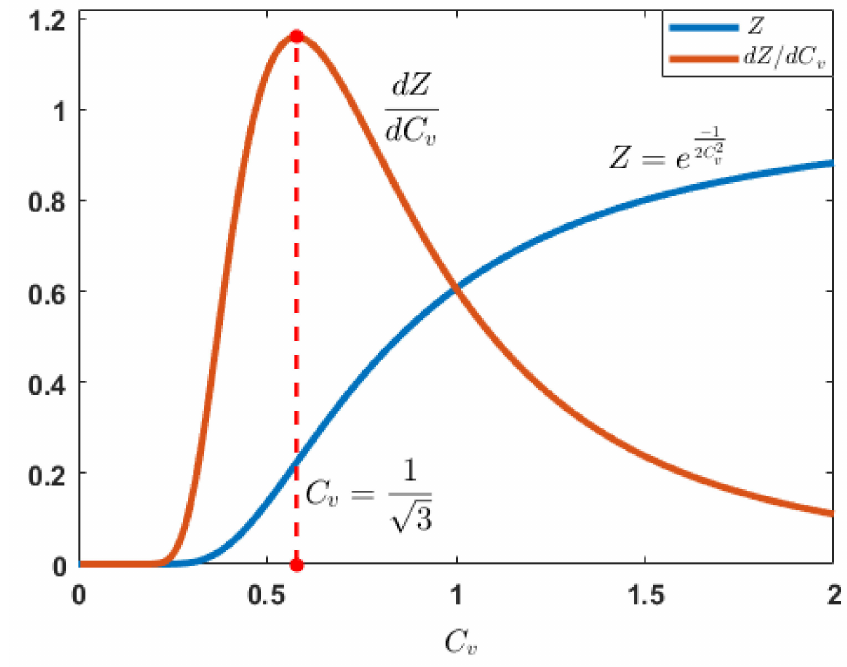
Figure 4. Bhattacharyya parameter optimized design point for AWGN